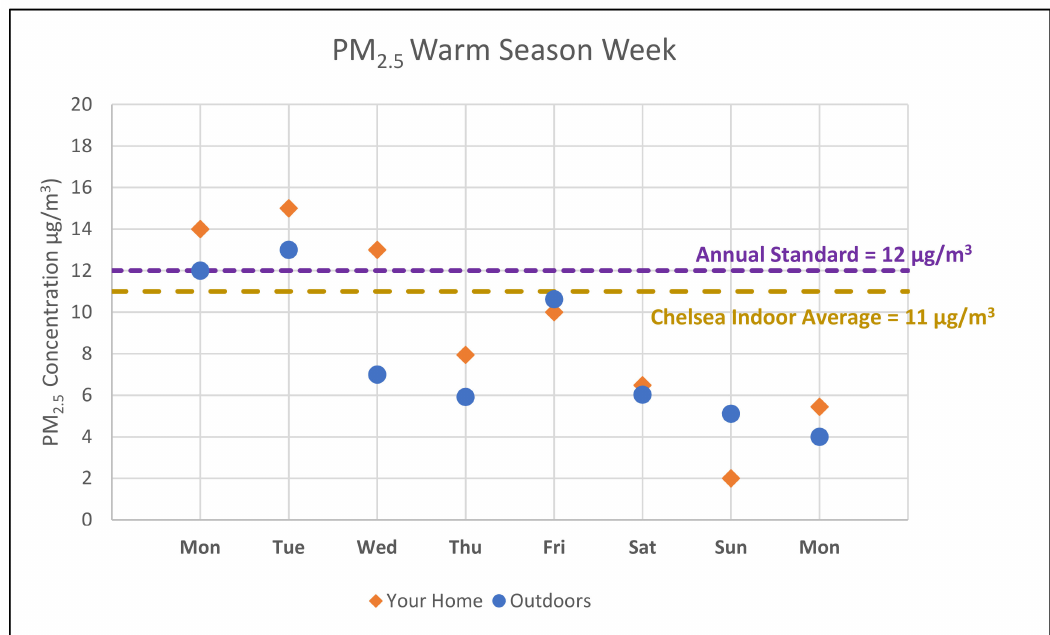
Figure 3. Example of the graphical component from report-back